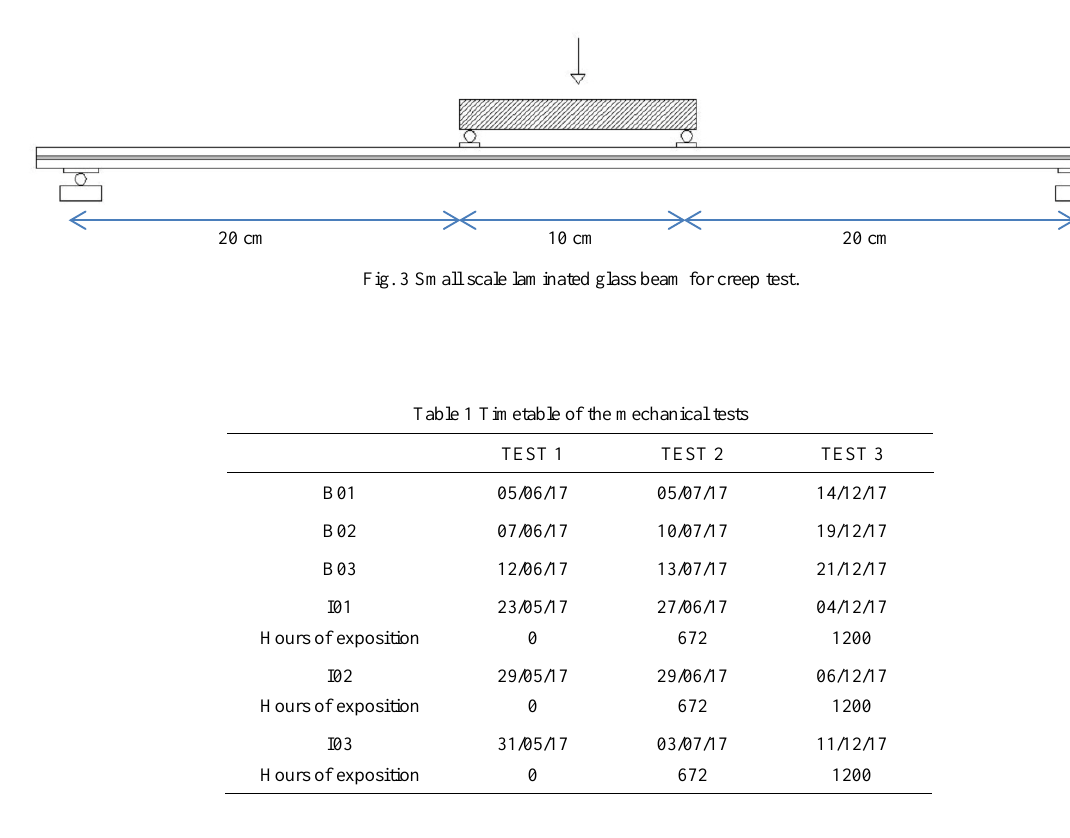
Fig. 2 Optimal distance from the lamps to obtain about 900 ±100 W/m 2 .